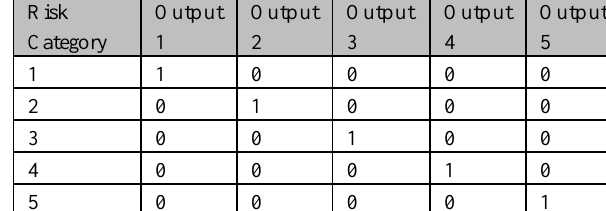
Table 7. Binary coding of output factor in the study.